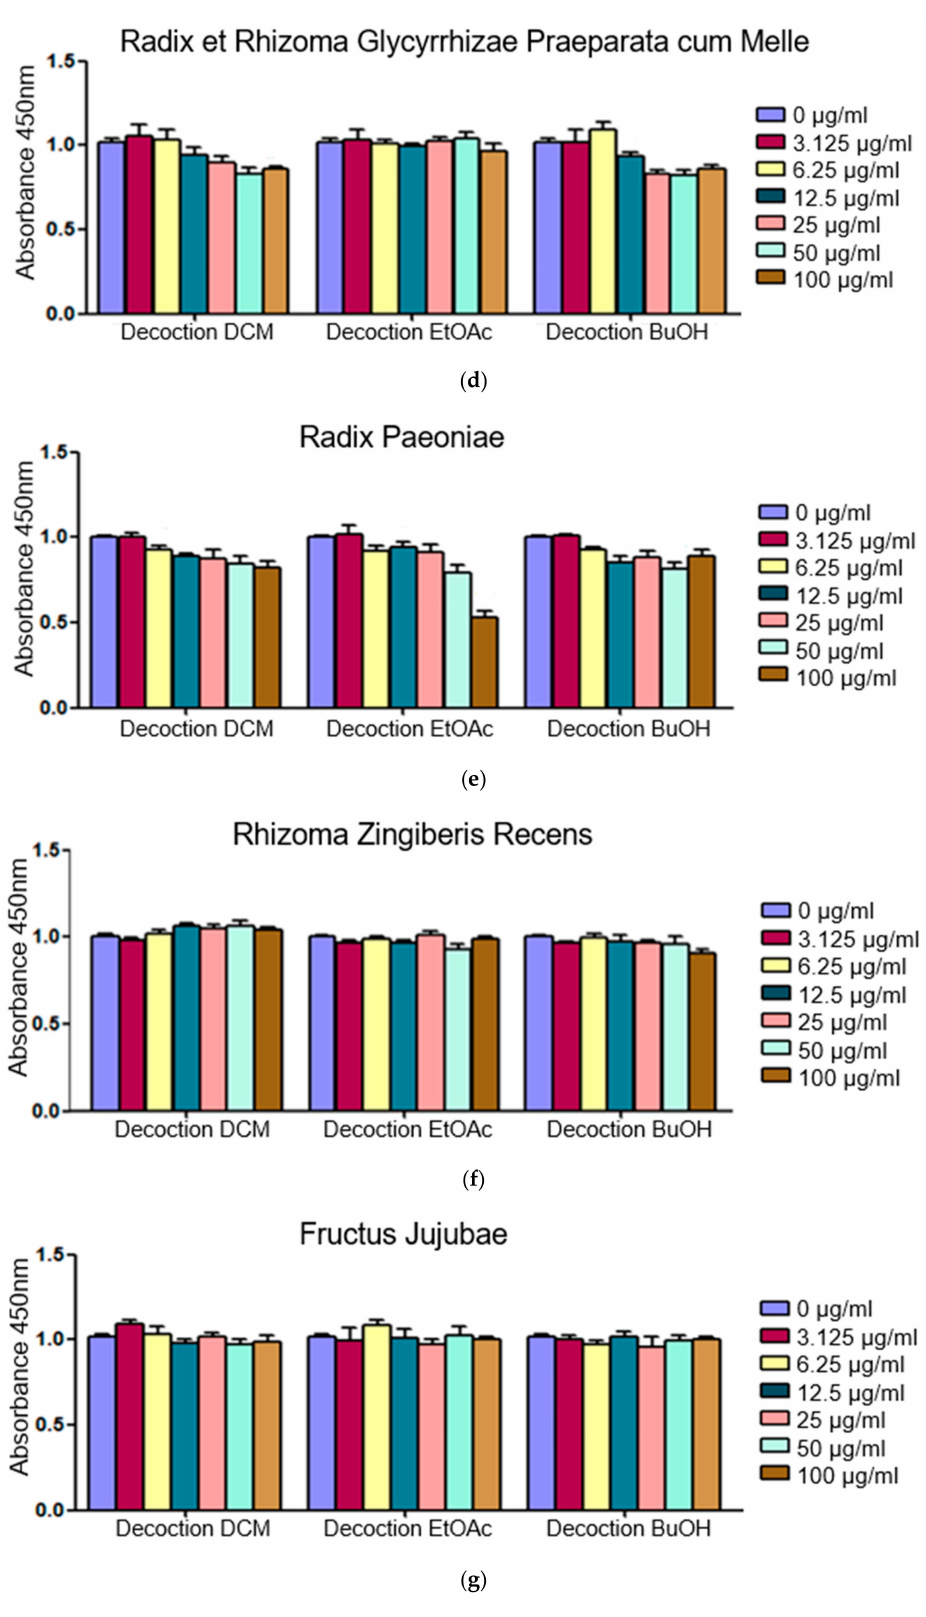
Figure A1. E ff ects of the extracts from the decoctions on cell viability; ( a ) HQJZT; ( b ) RA; ( c ) RC; ( d ) RRGP; ( e ) RP; ( f ) RZ; ( g ) FJ; n = 3; mean